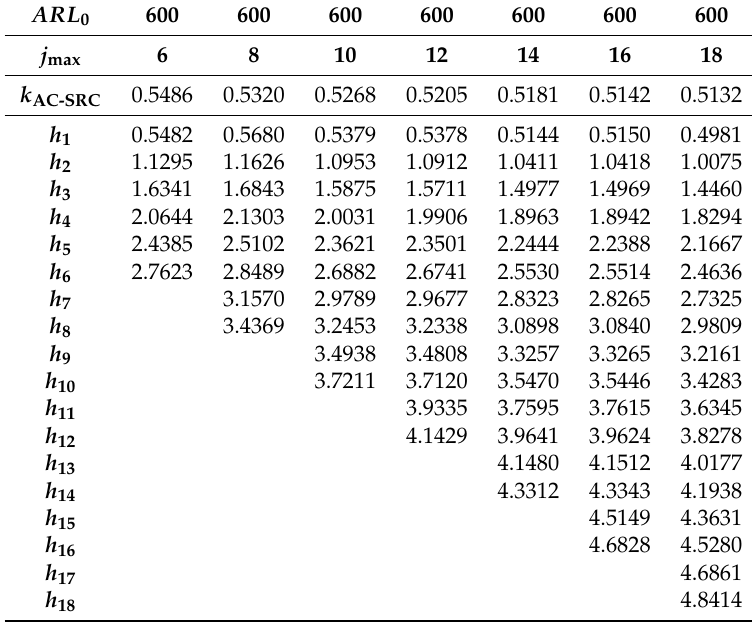
Table A7. AC-SRC for ARL 0 =